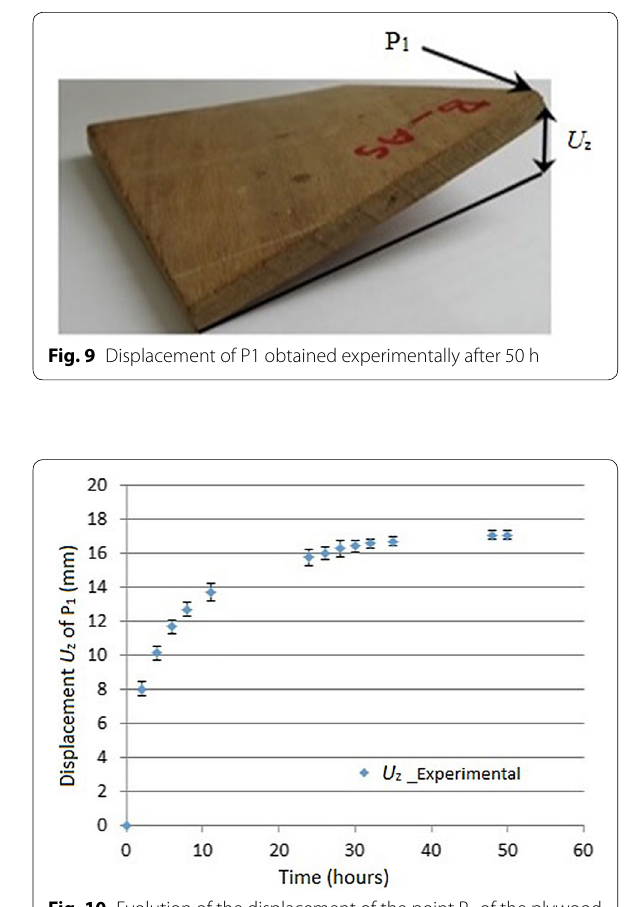
Fig. 10 Evolution of the displacement of the point P 1 of the